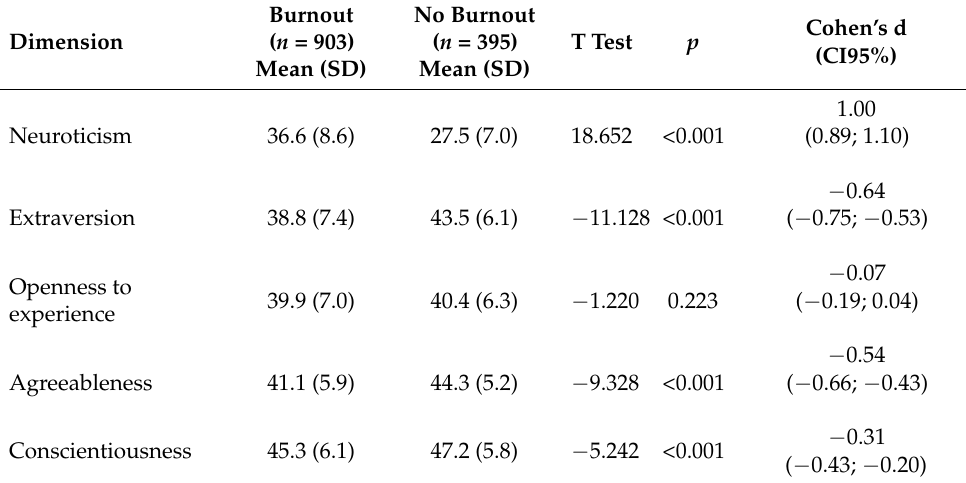
Table 3. Means and standard deviations, independent samples t and p values, and magnitude of the difference between groups between groups in the dimensions of the NEO-FFI personality questionnaire, classified by whether high scores in at least one dimension of burnout or no burnout were detected.